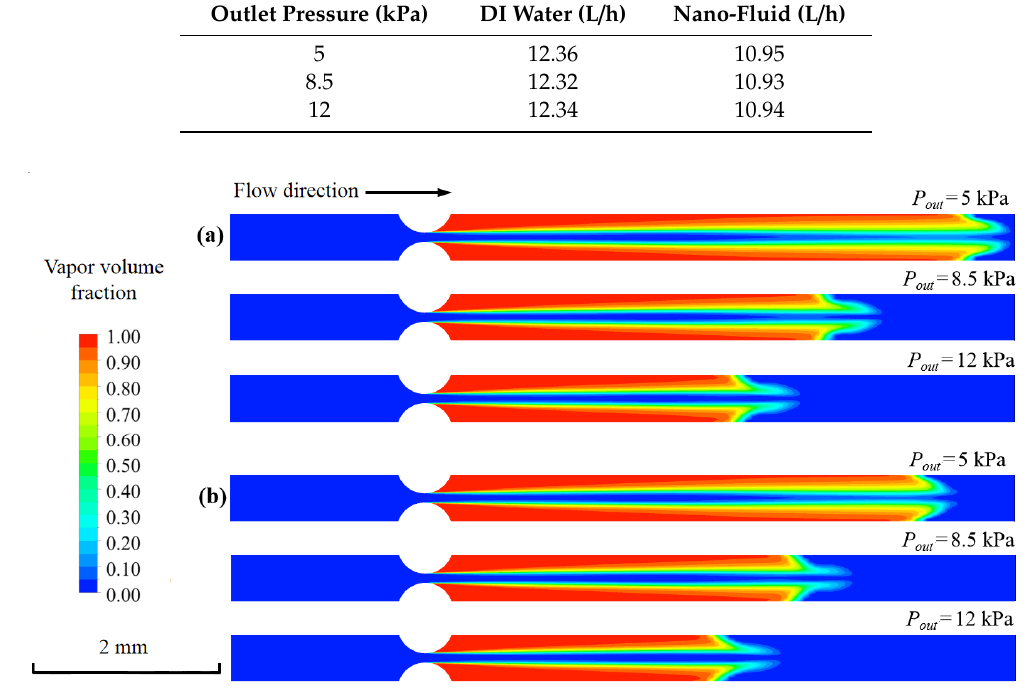
Figure 13. The vapor volume fraction with various outlet pressure: ( a ) DI water and ( b ) nano-fluid.